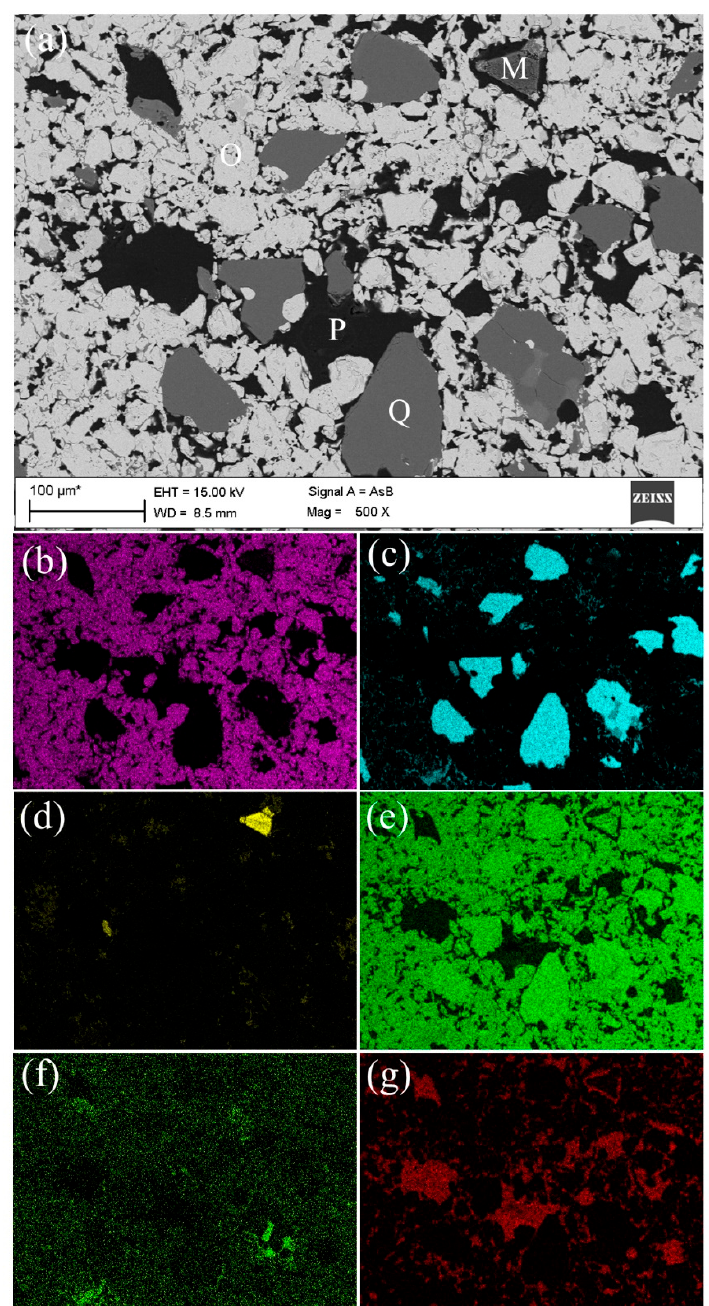
Figure 3. FESEM-EDS mapping of elements of a fired pellet sized 10–12.7 mm. Figure ( a ) is the original backscattered electron image, and the EDS mapping of elements is presented in: ( b ) Fe, ( c ) Si, ( d ) Mg, ( e ) O, ( f ) K and ( g ) C (pores). “O” stands for iron oxides (hematite and/or magnetite), “M” for magnesite, “Q” for quartz and “P” for pore.